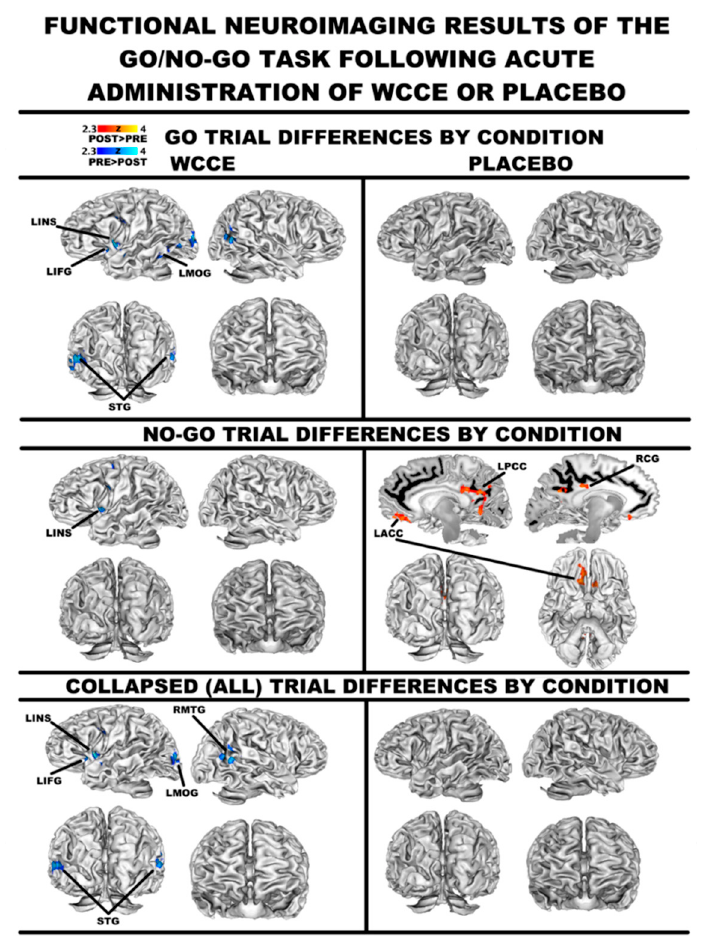
Figure 4. Differences in the pre–post consumption of WCCE or placebo for go trials (uppermost panel), no-go trials (middle panel), and all trials collapsed (bottom panel). In all panels, WCCE is presented on the left side, and the placebo is presented on the right. Statistic images were thresholded on magnitude ( z ≥ 2.3), as well as cluster extent-determined by z > 2.3 and a corrected cluster significance threshold of p < 0.05. Local maxima tables for each contrast are available at https://osf.io/qypr8/. Abbreviations: LACC = left anterior cingulate cortex; LIFG = left inferior frontal gyrus; LINS = left insula; LMOG = left middle occipital gyrus; LPCC = left posterior cingulate cortex; RCG = right cingulate gyrus; and STG = superior temporal gyrus. N-back: Post-WCCE ingestion was associated with greater right posterior cingulate (BA 29/30), parahippocampal (BA 30), and culmen activity during rest periods compared to pre-ingestion (please see https://osf.io/qypr8/ for a listing of coordinates). No differences were observed for the